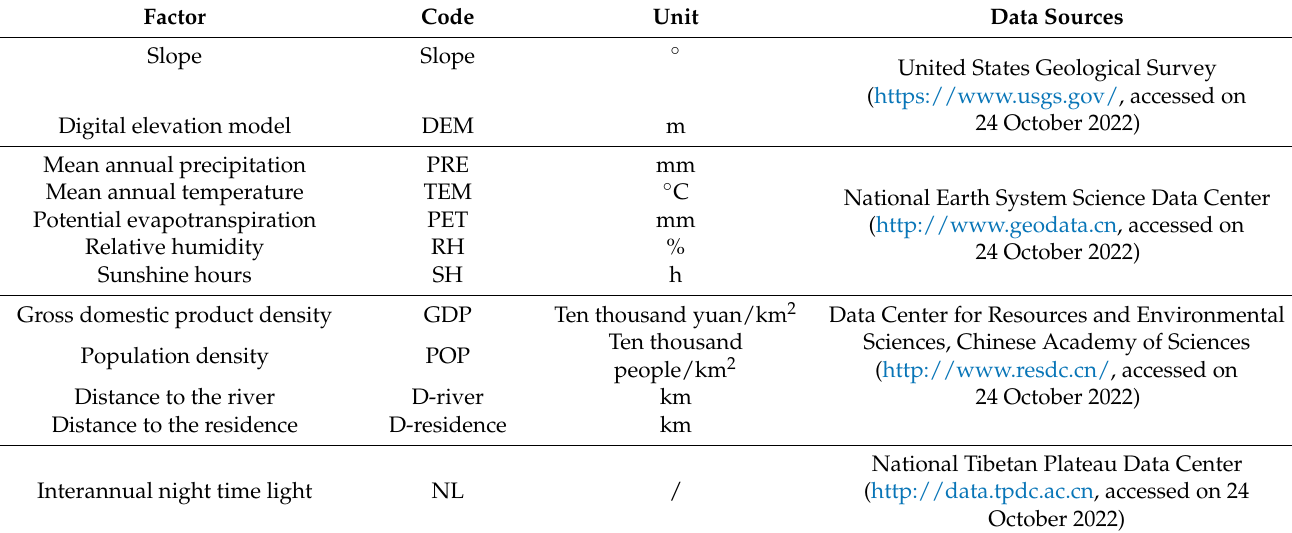
Table 1. List of relevant factor